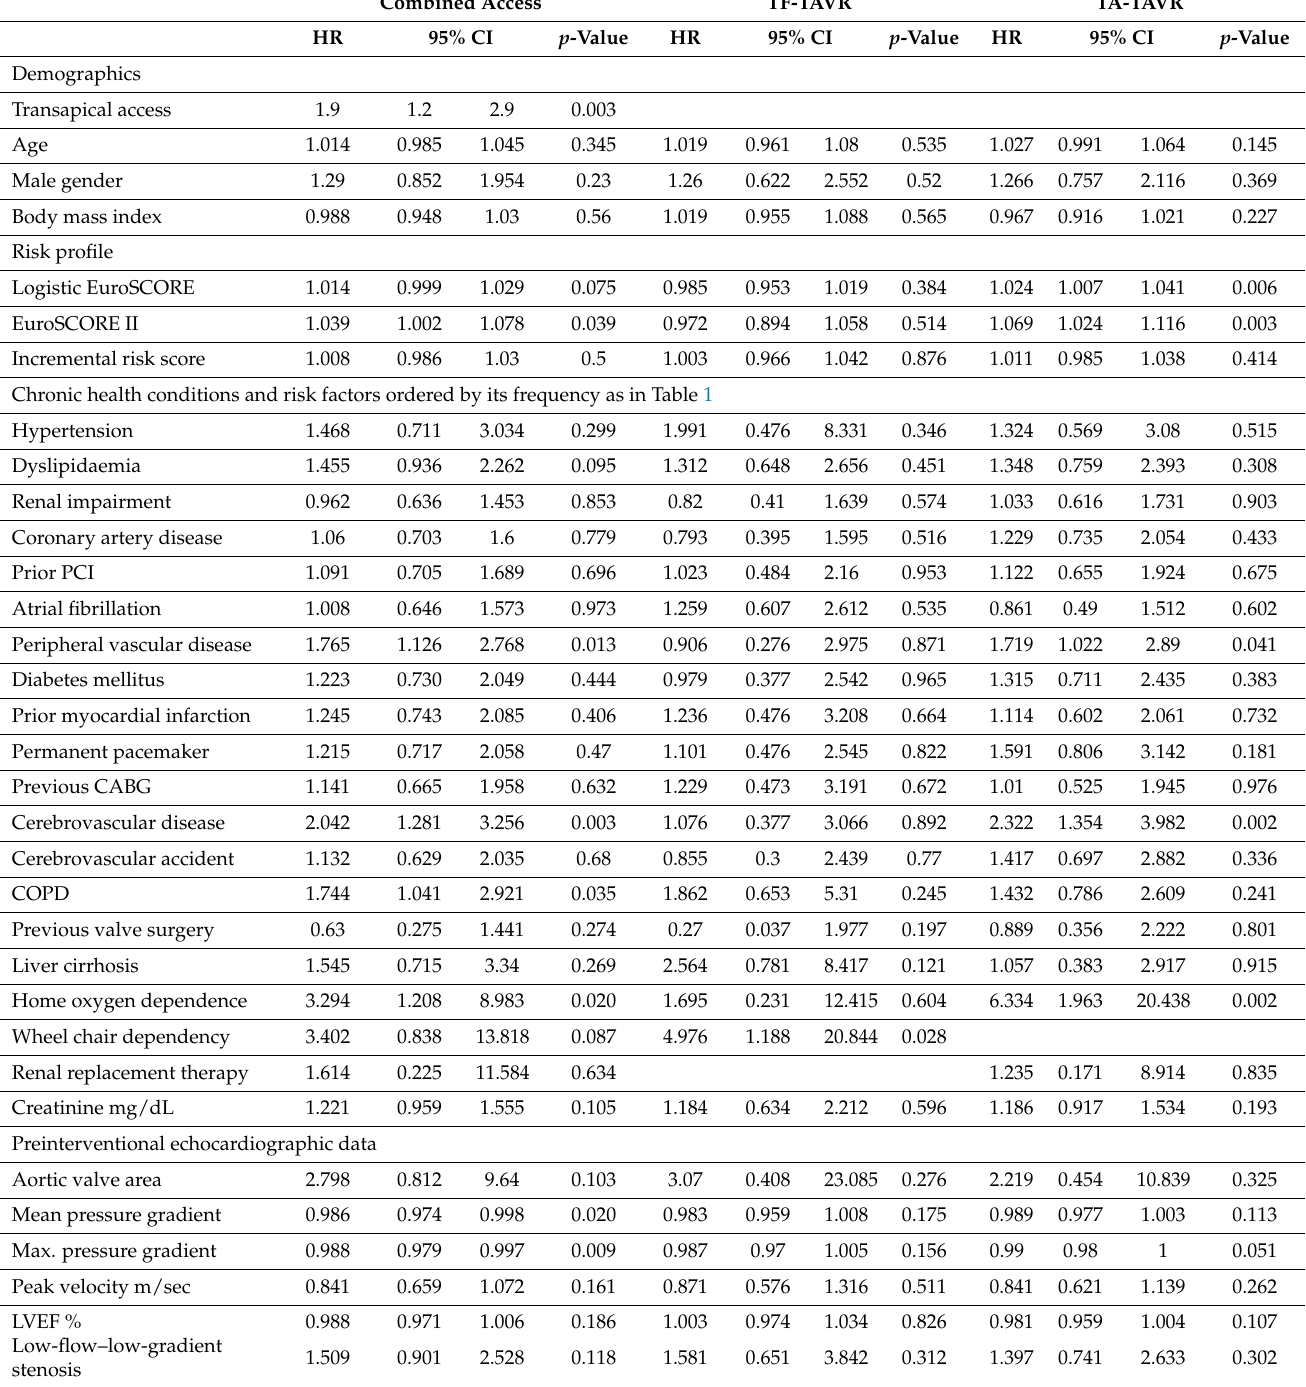
Table 2. Univariate Cox regression analyses of futile events based on patients’ baseline characteristics of preinterventional factors. A hazard ratio (HR) above 1 increases the risk, below 1 decreases the risk of